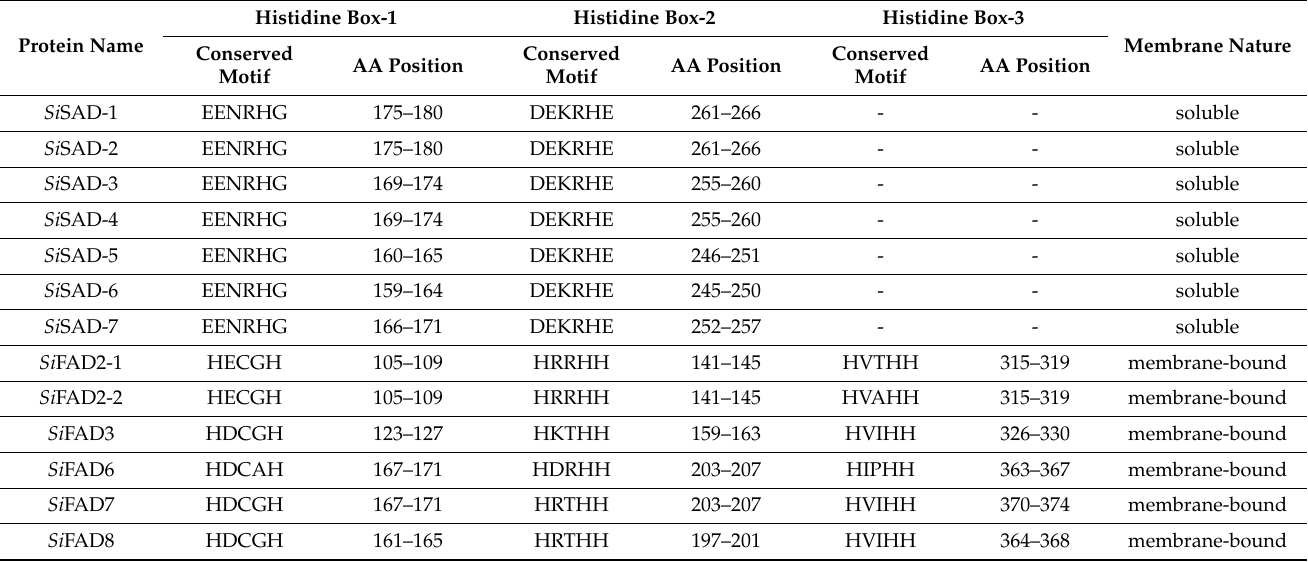
Table 1. Conserved histidine-rich boxes for the FAD family members identified in sesame.